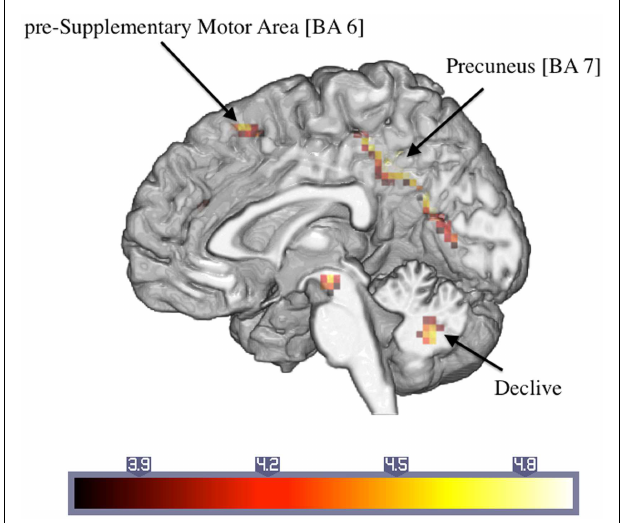
FIGURE 2 | Significantly activated areas inASD patients compared to controls with regard to the response to the trauma-related versus neutral pictures (number in brackets indicate Brodmann areas)